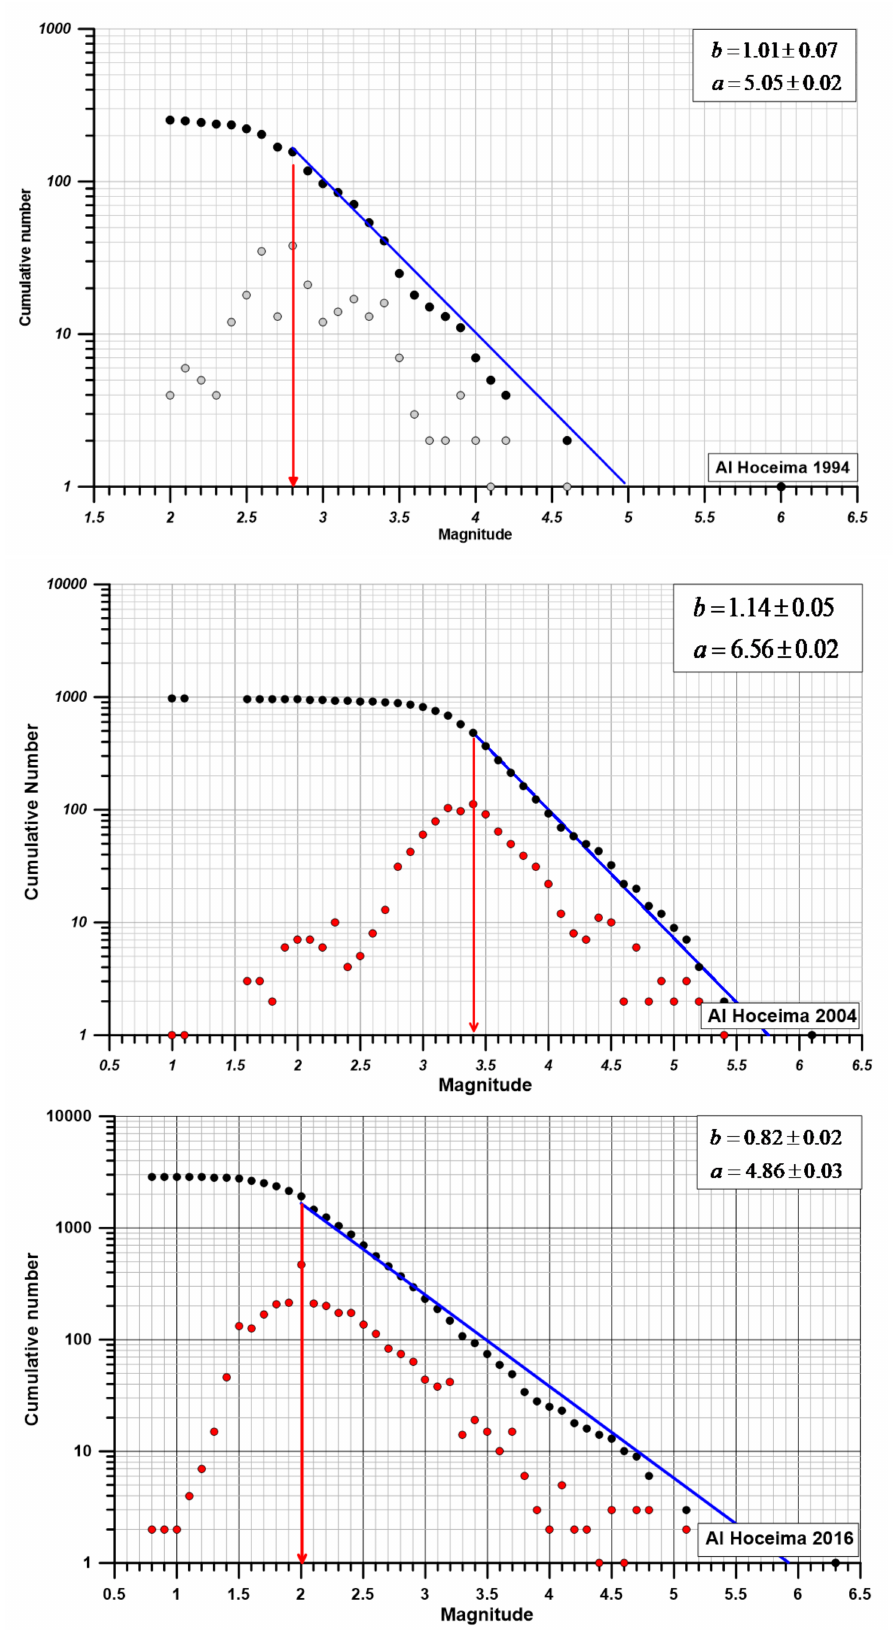
Figure 9. The cumulative number of earthquakes vs. magnitude (black points and linear fits) and the non-cumulative number of earthquakes (open points) for the three sequences. The threshold magnitude is